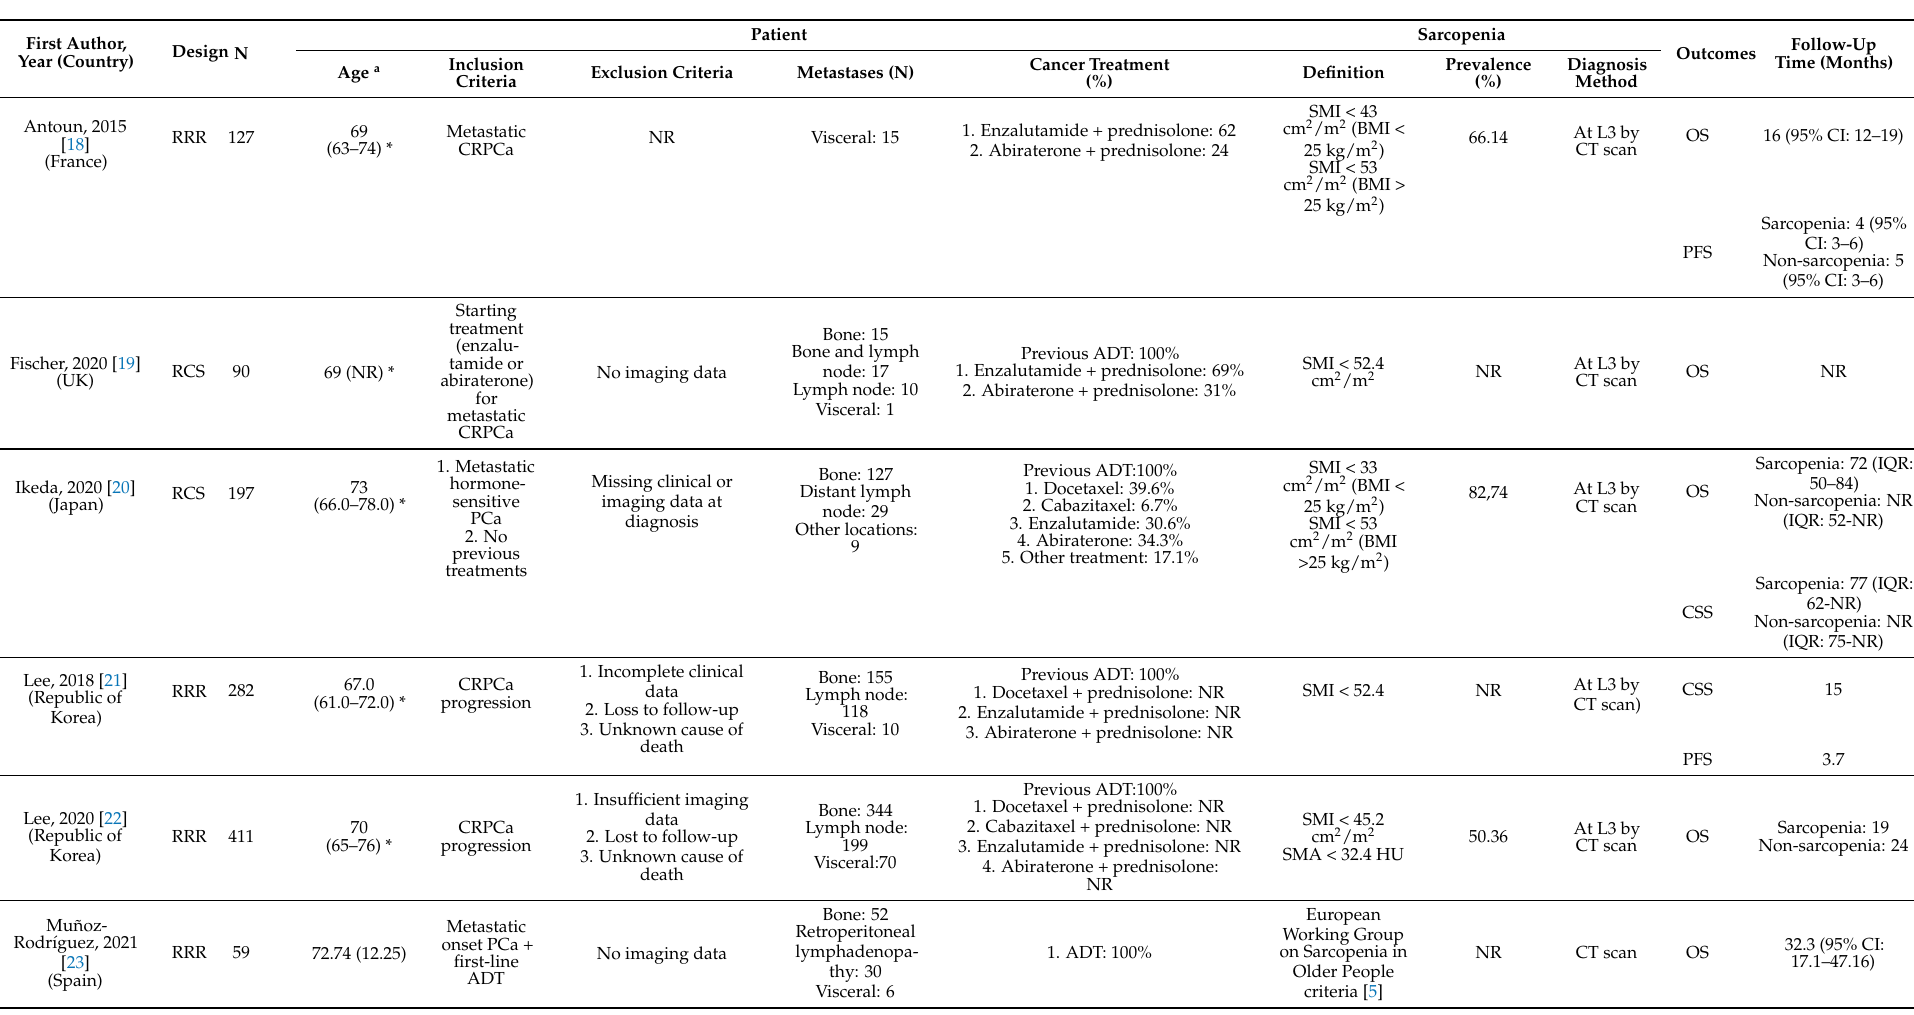
Table 1. Characteristics of included